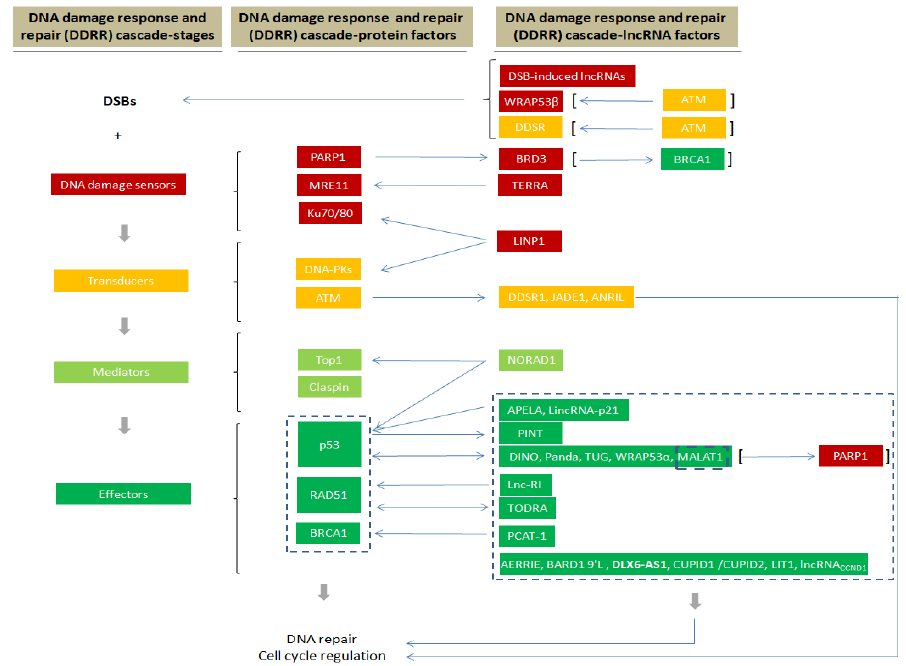
Figure 1. Schematic illustration of how lncRNAs are involved in the various stages of DDRR signaling.